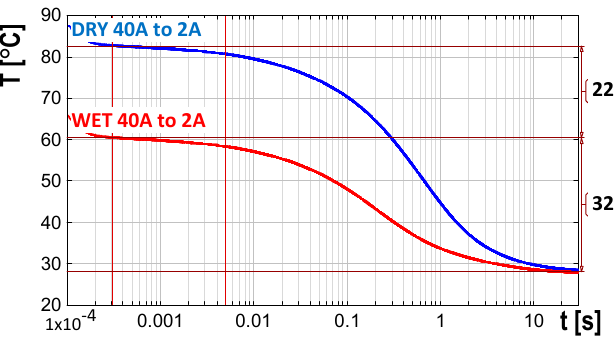
Figure 5. Measured cooling transients at “dry” and “wet” boundary conditions (from [11]).